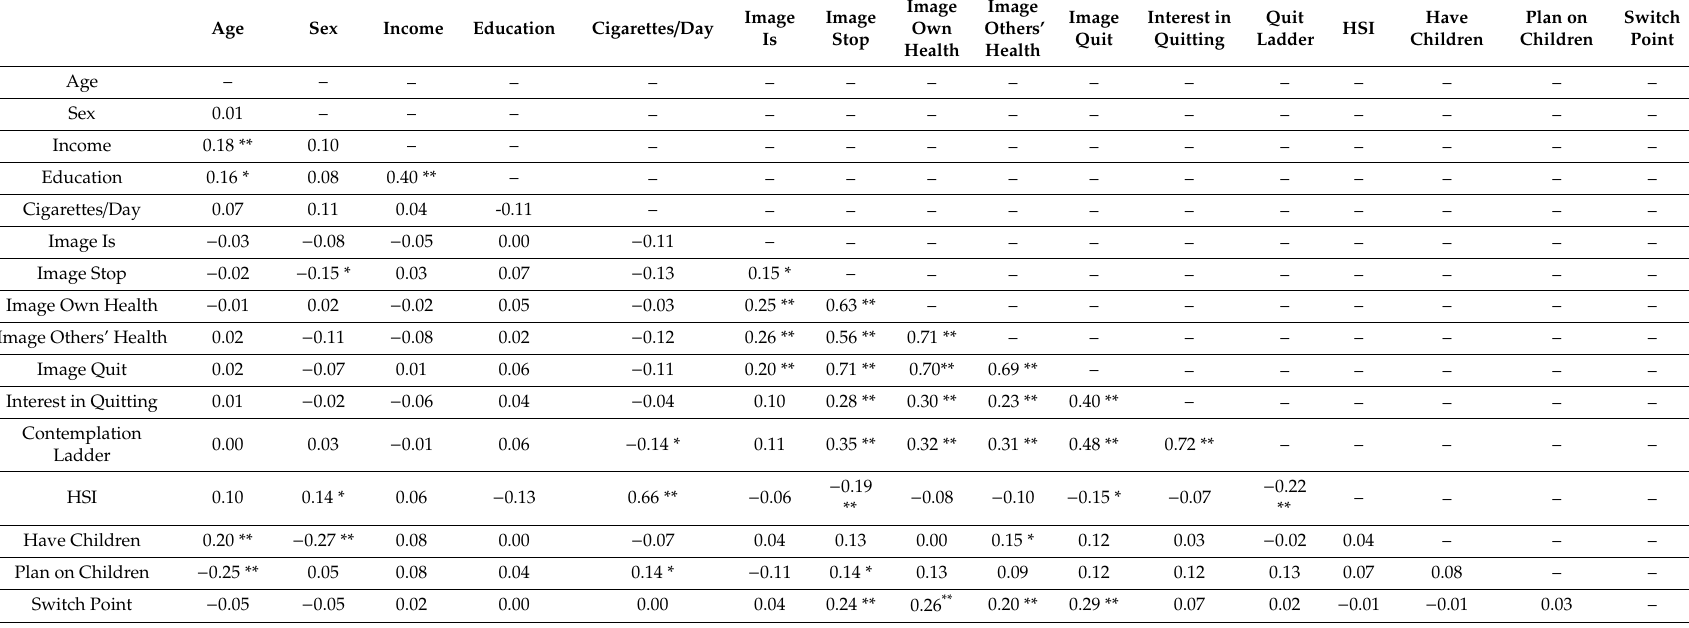
Table 2. Spearman’s rho correlation matrix for demographic variables, smoking characteristics, image variables, and switch